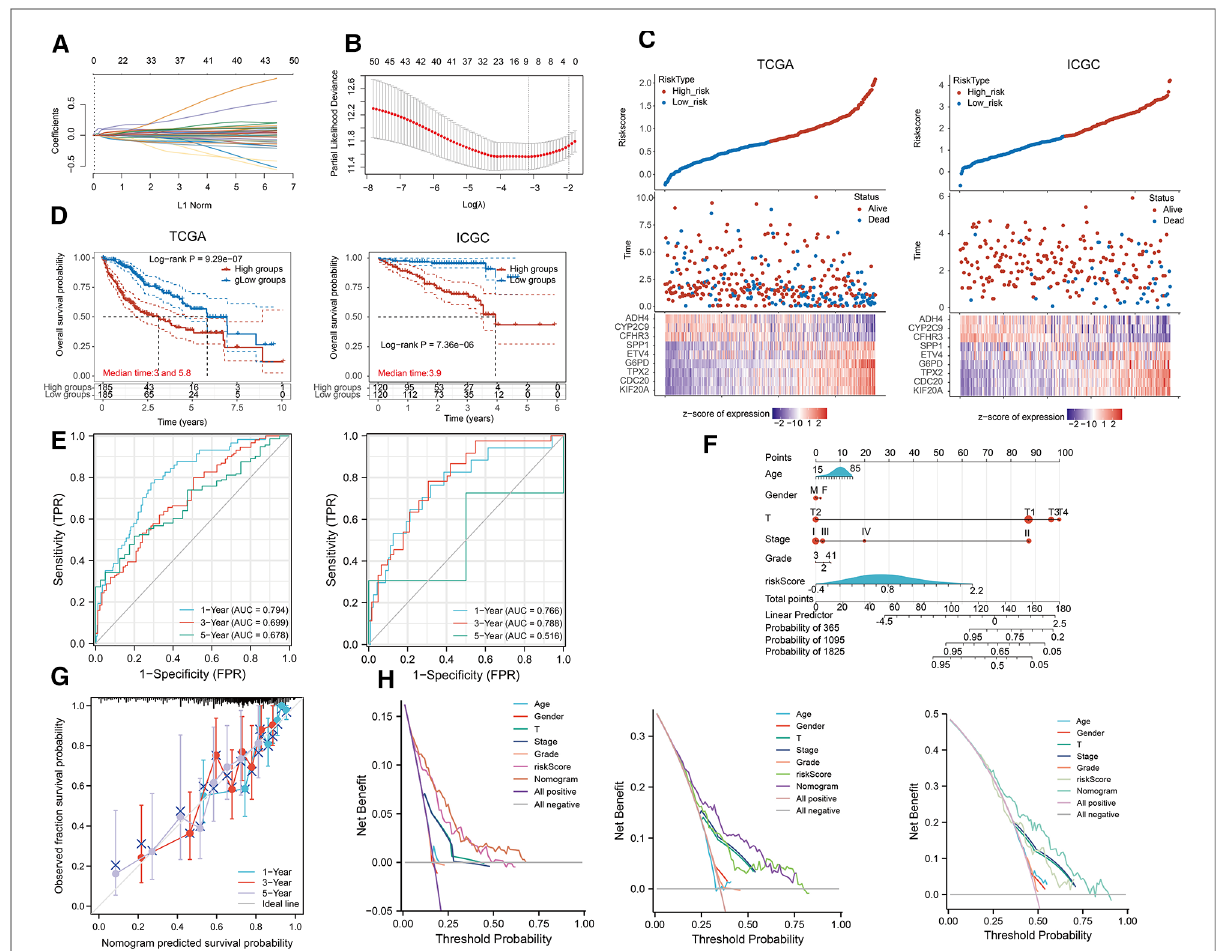
FIGURE 6 Development of prognostic model based on DEGs. ( A,B ) LASSO Cox regression model. ( C ) Heatmap illustrated the distribution of HCC patients according to their status in TCGA and ICGC pro fi les. ( D ) KM curves for the different groups of risk scores. ( E ) ROC curves for the short and long terms prediction of prognosis. ( F ) Construction of a nomogram by integrating clinical factors and risk scores. ( G ) The calibration plots for the calculation of 1-, 3- and 5-year prognosis. ( H ) DCA validated the performance of the nomogram in evaluating 1-, 3- and 5-year